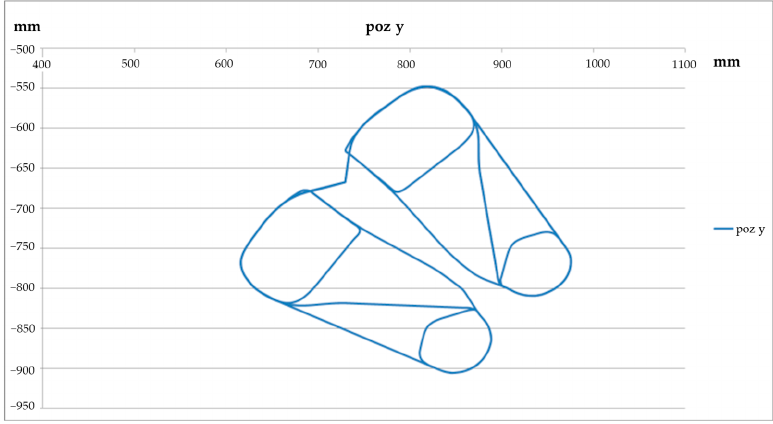
Figure 25. Complex trajectory plan.